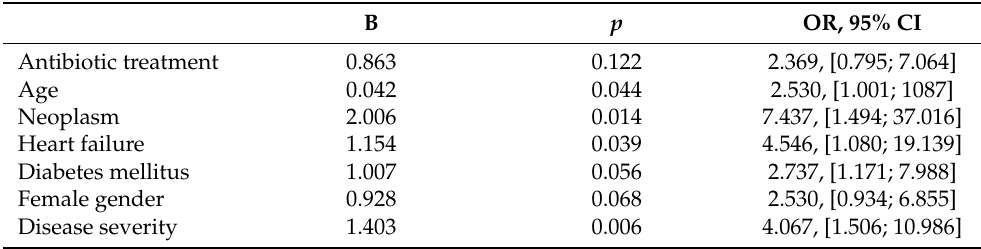
Table 3. Antibiotic therapy adjusted for several comorbidities that were highly associated with mortality (logistic regression).